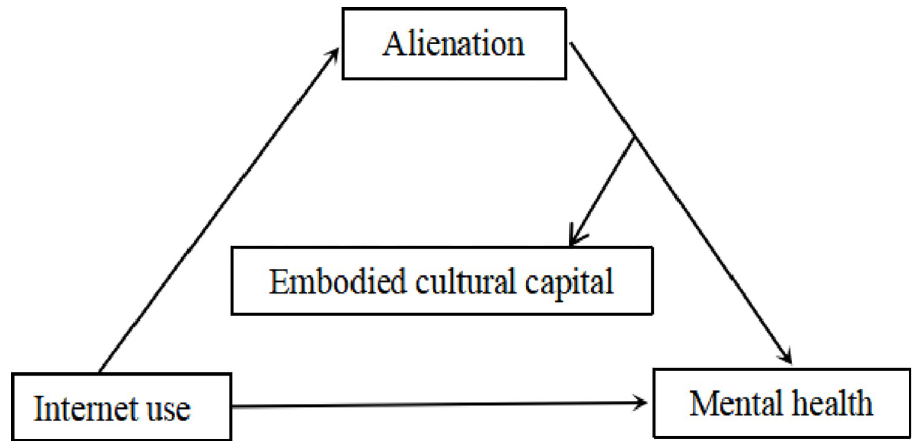
Fig 1. Hypothesis model. The mediation effect of alienation in the relationship between internet use and mental health. The moderation effect of embodied cultural capital in the relationship between alienation and mental health.